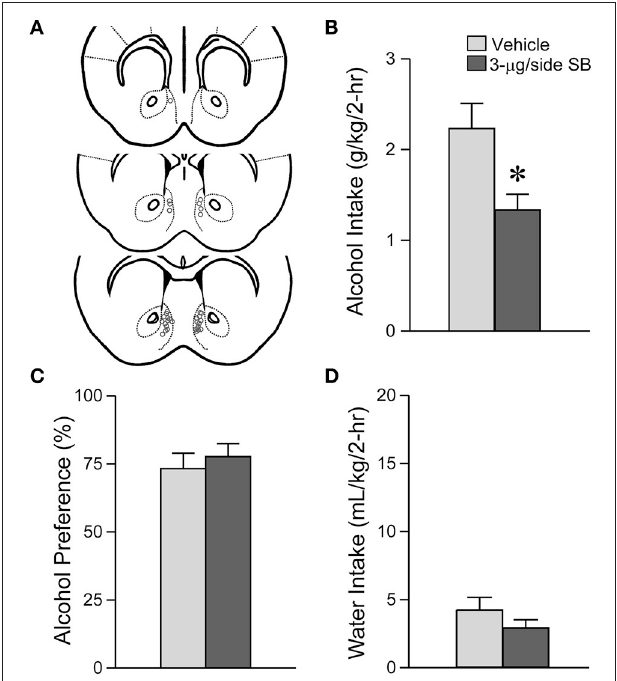
FIGURE 2 | mNAsh OX1R blockade did not alter saccharin drinking. (A) Locations of cannulae, as for Figure 1 . (B–D) Infusion of 3- µ g SB within